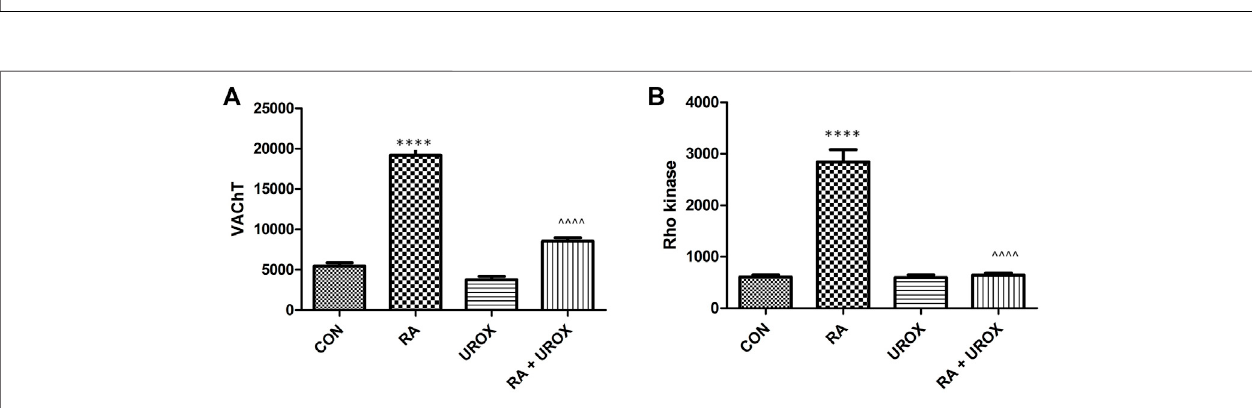
FIGURE 3 | The in fl uence of the 14-day administration of Urox ® (840 mg p.o.) on biomarkers ’ level (pg/ml) in urine: (A) BDNF and (B) NGF in rats subjected to a singleinjectionofretinylacetate(RA).Valuesareexpressedasmean±SEM.**** p < 0.001 versus saline, ^^^^ p < 0.0001 versus RA( n =15ratspergroup).One-wayANOVA: for BDNF: F(3.56) = 52, p < 0.0001; and for NGF: F(3.56) = 19, p < 0.0001; CON, control.